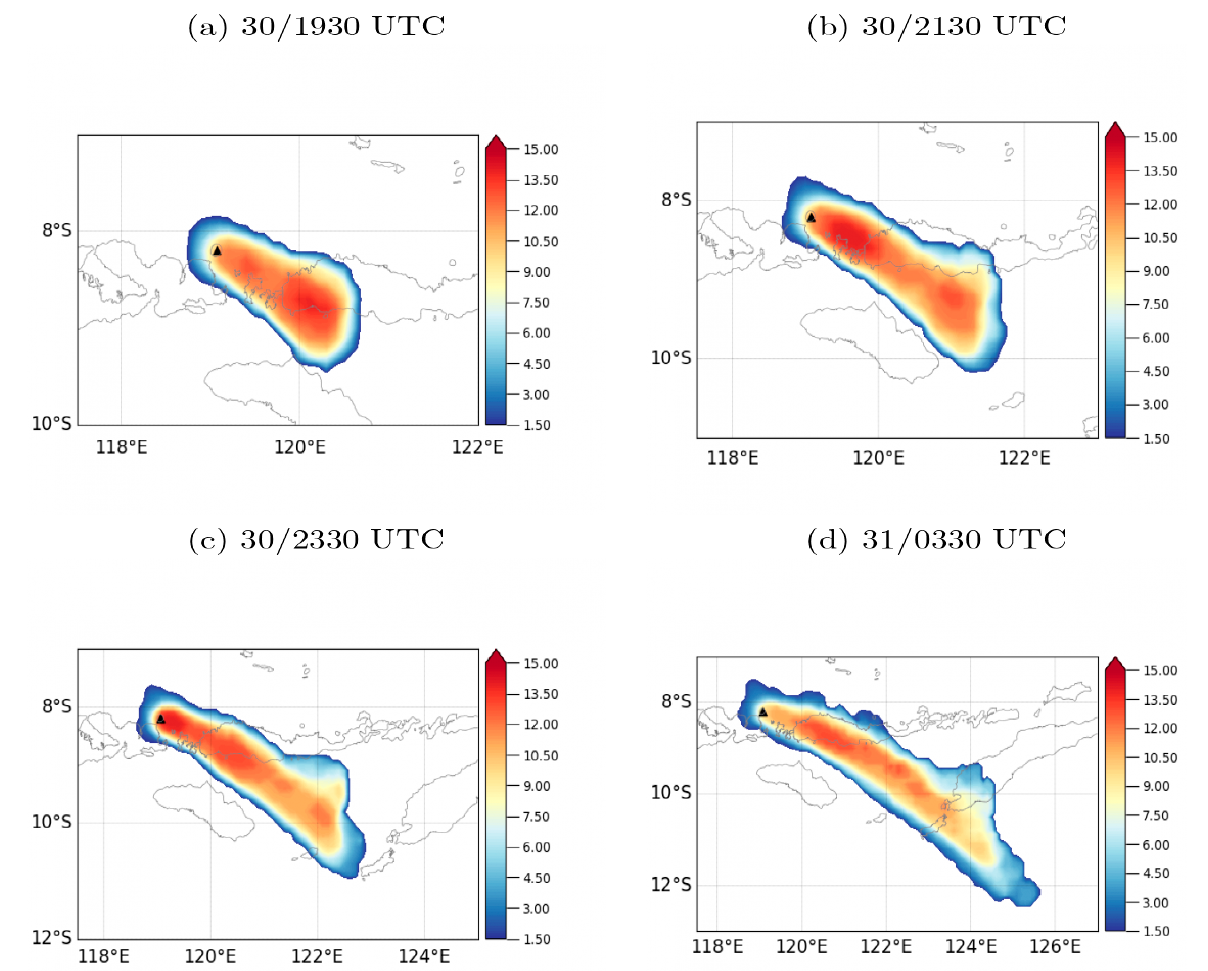
Figure 7. Ensemble mean cloud top height fields (in km) obtained from an experiment employing the time varying prior and posterior source height functions shown in Figure 1c,d. The black triangle indicates the volcano location.